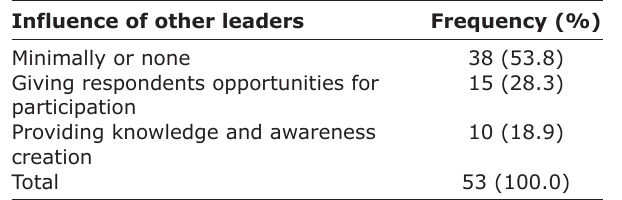
Table-7: Respondents’ views on how other leaders influence them in the OH